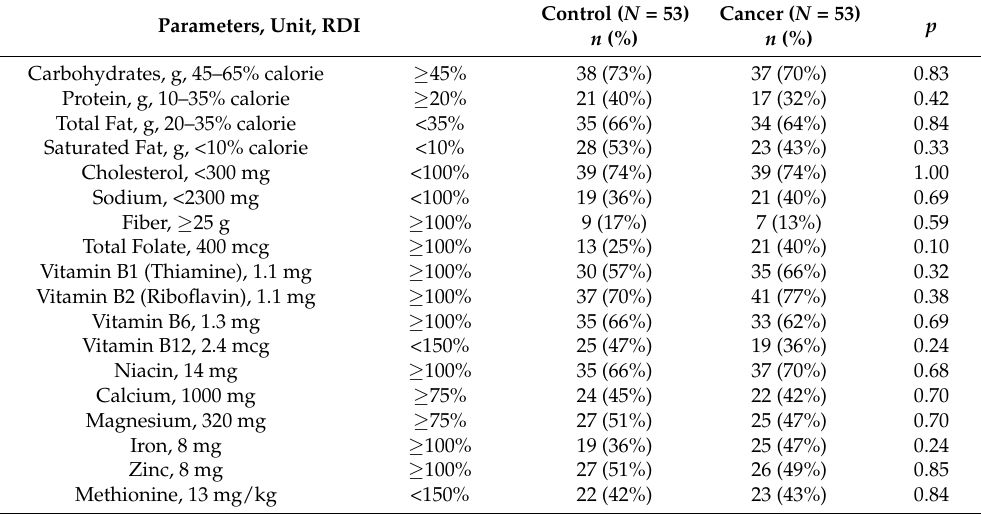
Table 3. Comparisons of recommended daily intakes between control and cancer